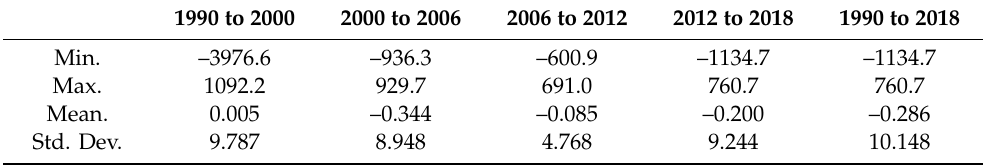
Table 4. Descriptive statistics on the e ff ects of LULC changes on erosion estimates (in t / ha / y).